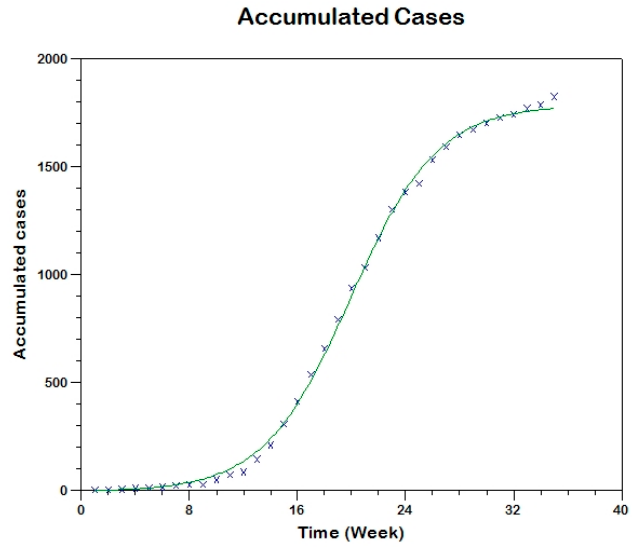
Figure 10 . Model fit to the cumulative reported incidence of the first outbreak in Tolima-Colombia using Method 0.